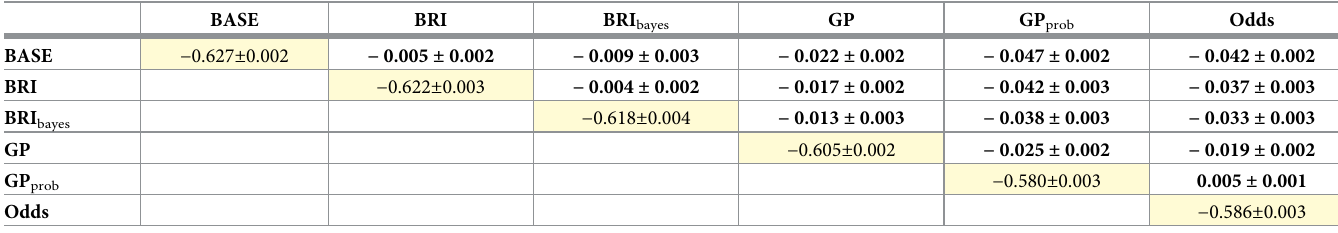
Table 4. Model performance on NBA data set.